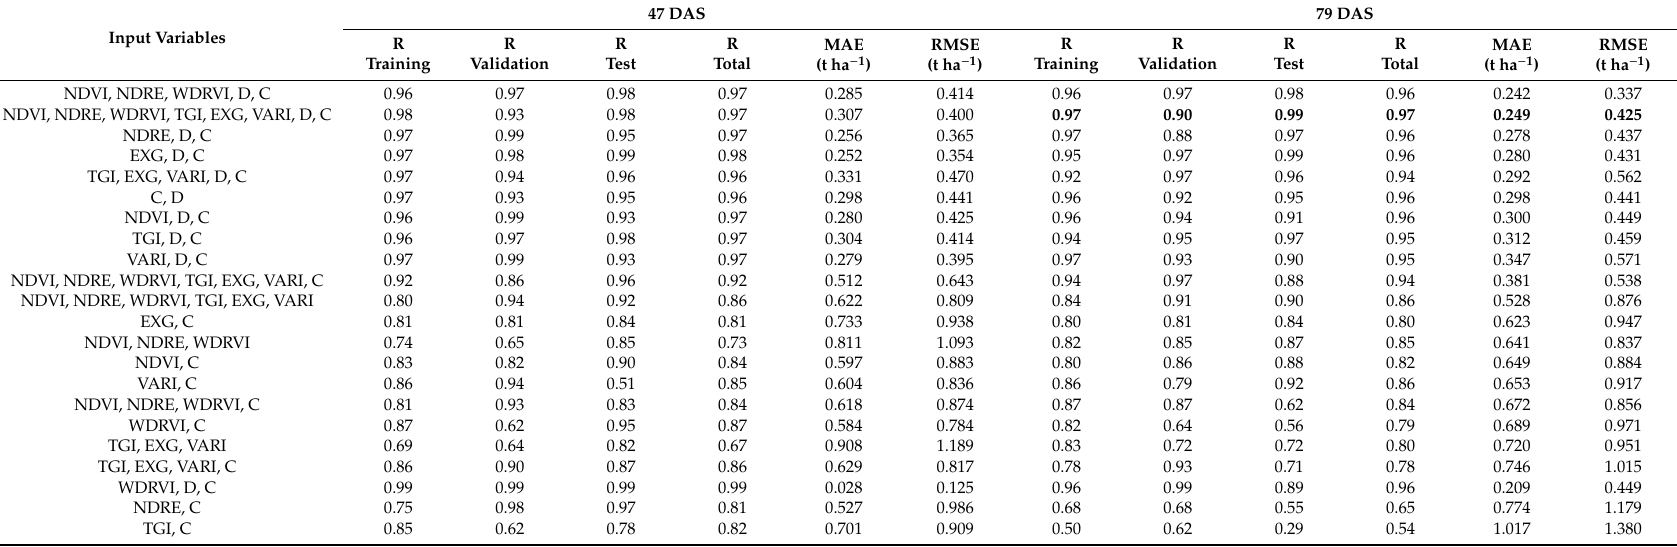
Table 4. Training, validation, and testing of the artificial neural network with di ff erent input variables from vegetation indices, plant density, and canopy cover for the estimation of corn grain yield at 47 and 79 days after sowing